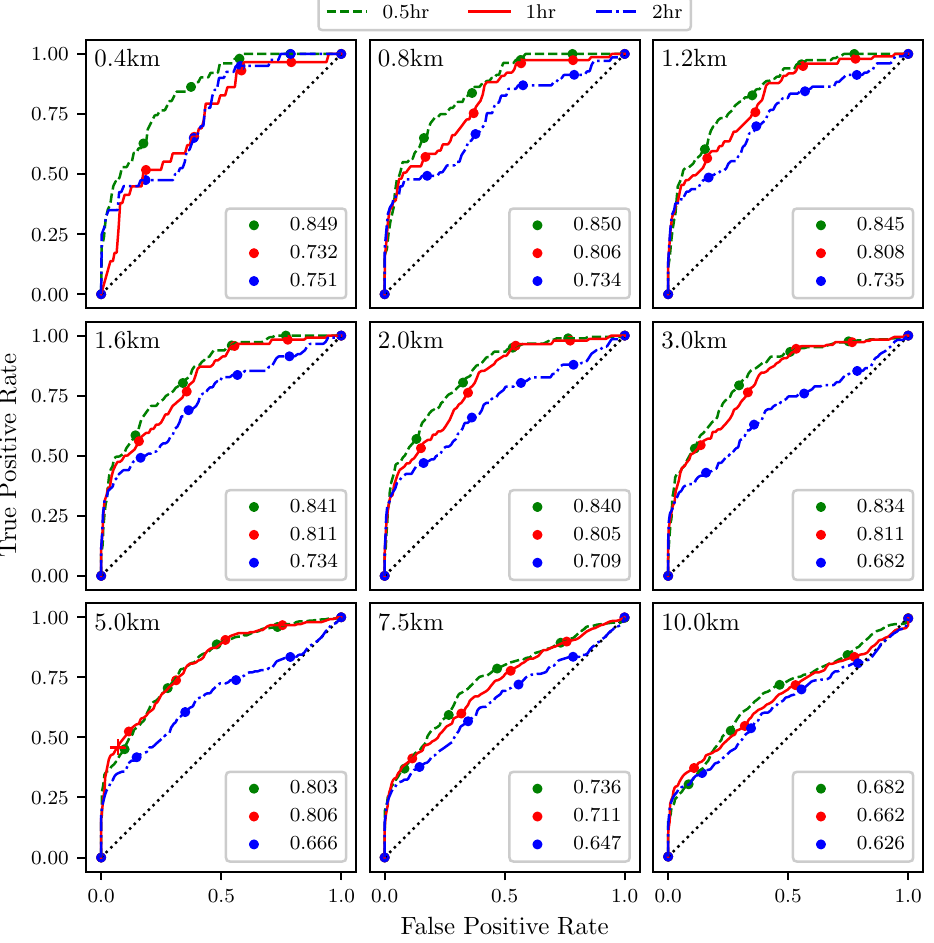
Figure 14. ROC curves for the attraction rate, s 1 , as measured at the center point ability to detect 90th percentile LCSs with integration times of 0.5 ( green ), 1 ( red ), and 2 ( blue ) h. The threshold radius for each subplot is displayed in the upper left hand corner. The AUC for each integration time is given in the legend. The red “+” marker corresponds to the plot point for the case (i.e., threshold value and radius) that was shown in Figure